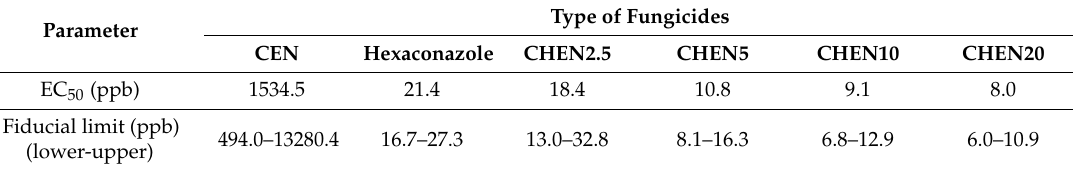
Table 3. Calculated EC 50 value of CEN, pure hexaconazole, and chitosan–hexaconazole